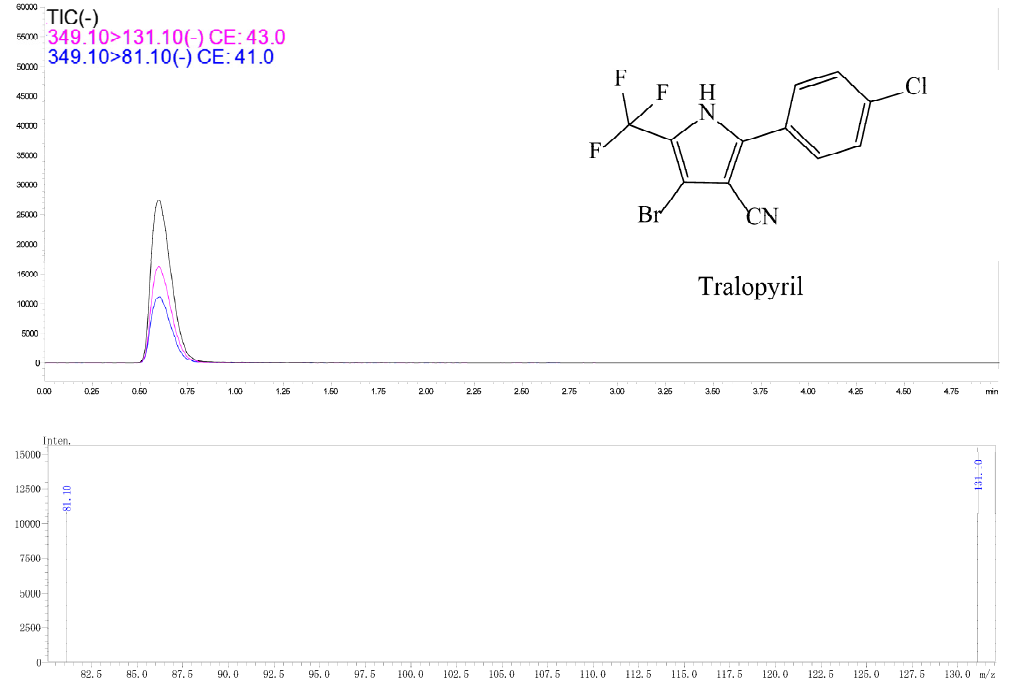
Figure 3. Typical spectra of tralopyril standard in acetonitrile detected by UPLC-MS/MS. The concentration of tralopyril was 0.1 mg/L.